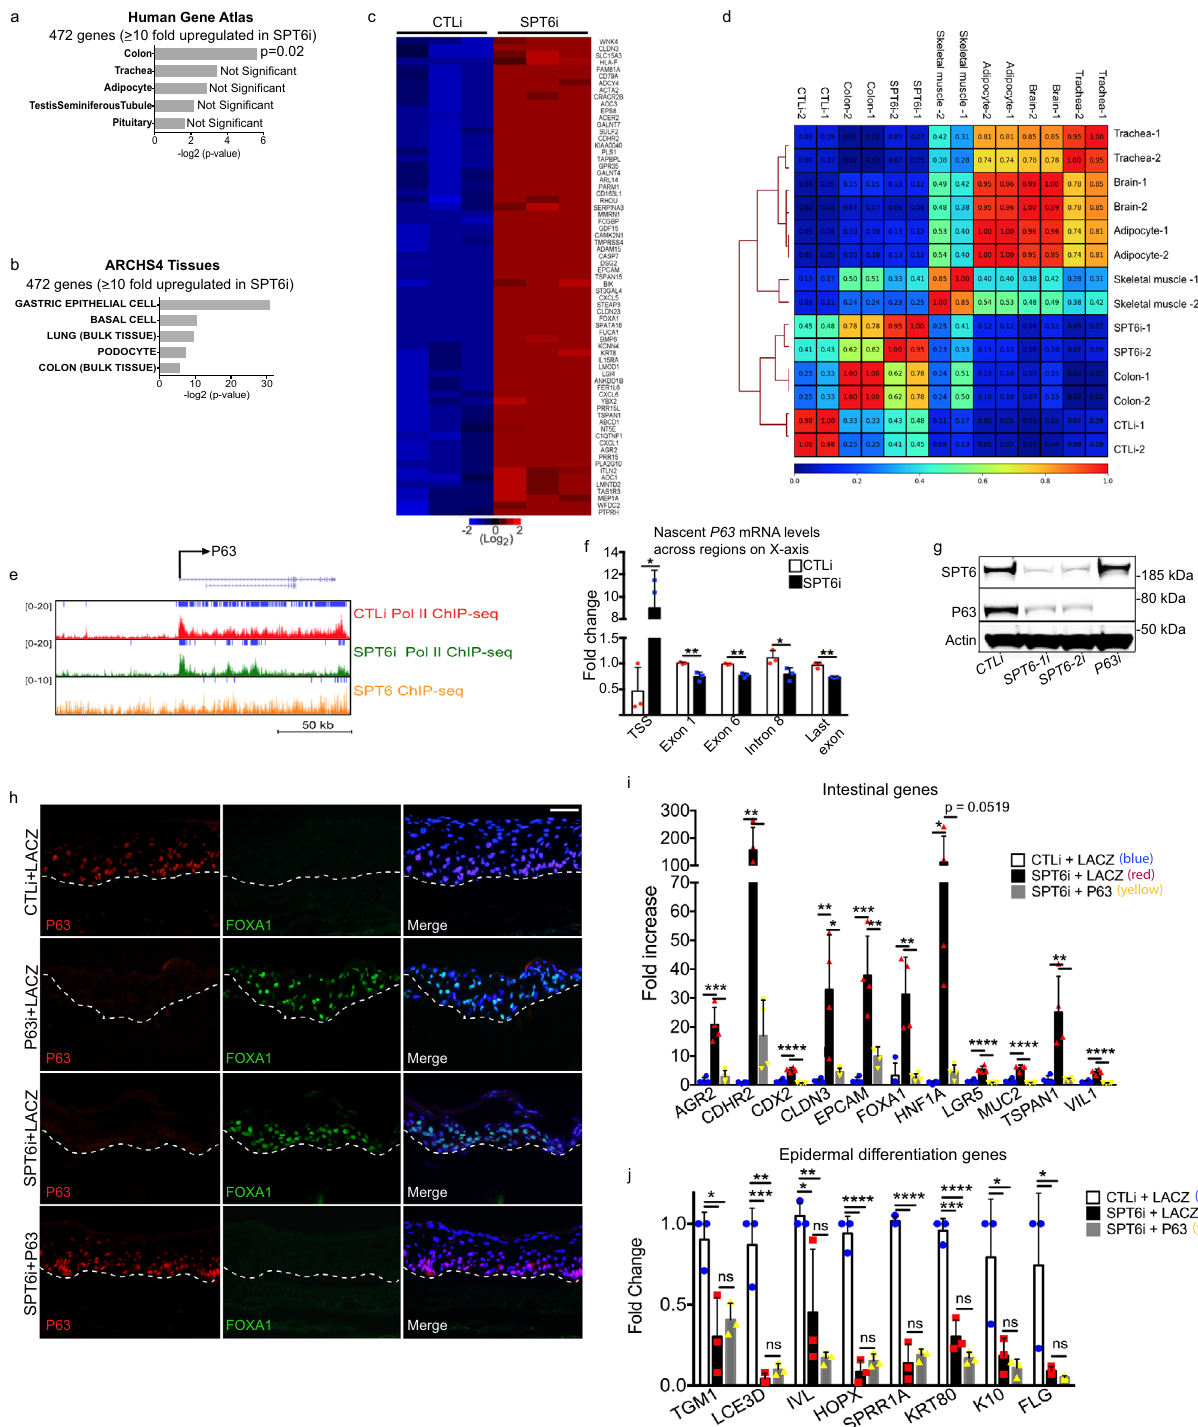
normal tissue and ARCHS4 is a compilation of 84,863 human RNA-Seq datasets covering a broad range of cell types and tissues. The only signi fi cant tissue that matched with the 472 upregulated genes was colon from the Human Gene Atlas (Fig. 6a). Similarly, gastric epithelial cells were the top match from the ARCHS4 Tissues database and matches to colon was also signi fi cant in the same database (Fig. 6b). A comparison between CTLi and SPT6i tissue showed that these intestinal genes (identi fi ed from the ARCHS4 database) were highly upregulated upon SPT6 loss and includes genes such as HNF1A , MUC2 , LGR5 , VIL1 , FOXA1 ,